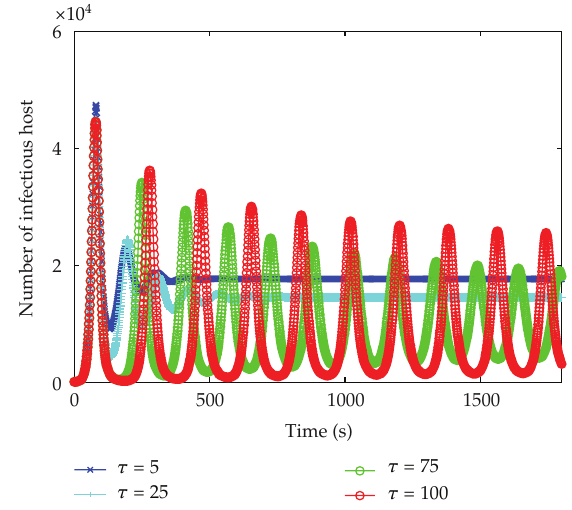
Figure 6: The number of infectious hosts when τ is changed in one coordinate.